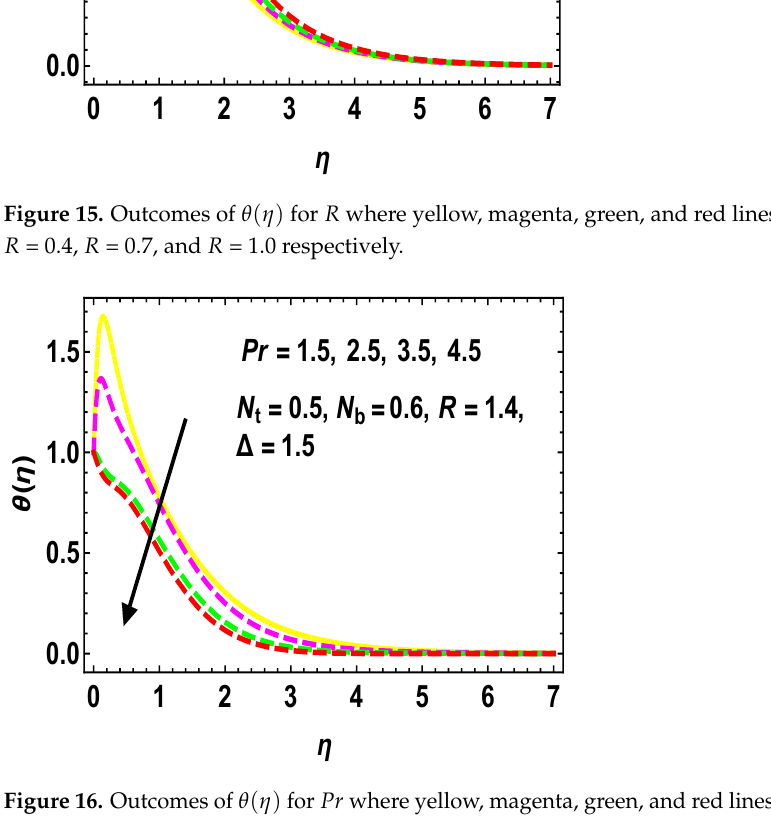
Figure 16. Outcomes of θ ( η ) for Pr where yellow, magenta, green, and red lines represent for Pr = 1.5, Pr = 2.5, Pr = 3.5, and Pr = 4.5